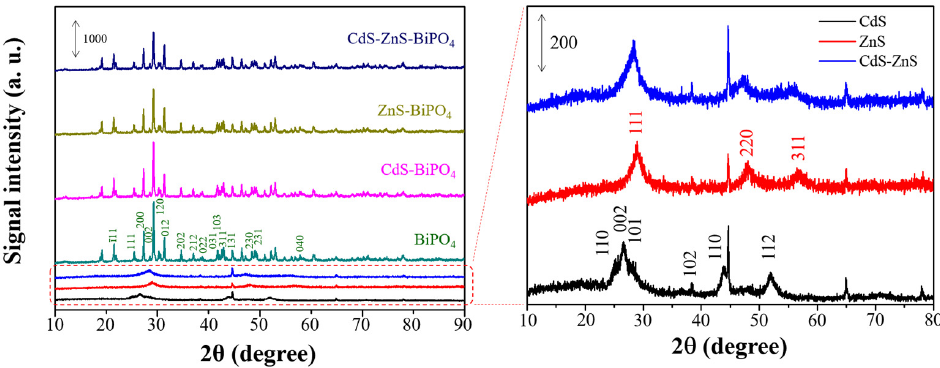
Figure 2. XRD spectra of CdS-BiPO 4 , ZnS-BiPO 4 , CdS-ZnS-BiPO 4 , CdS, ZnS, and CdS-ZnS samples.